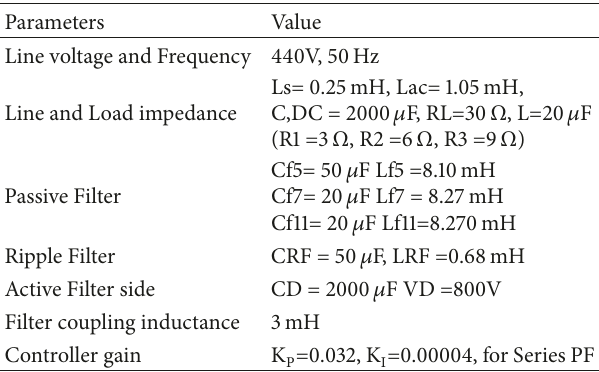
Table 3: Parameters in the